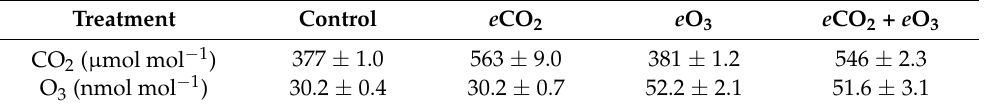
Table 1. CO 2 and O 3 concentrations in the free-air fumigation system. Values are means ± SD (n = 3) of daytime CO 2 and O 3 concentrations (6:00 to 18:00) during the growth season (May to November 2011).